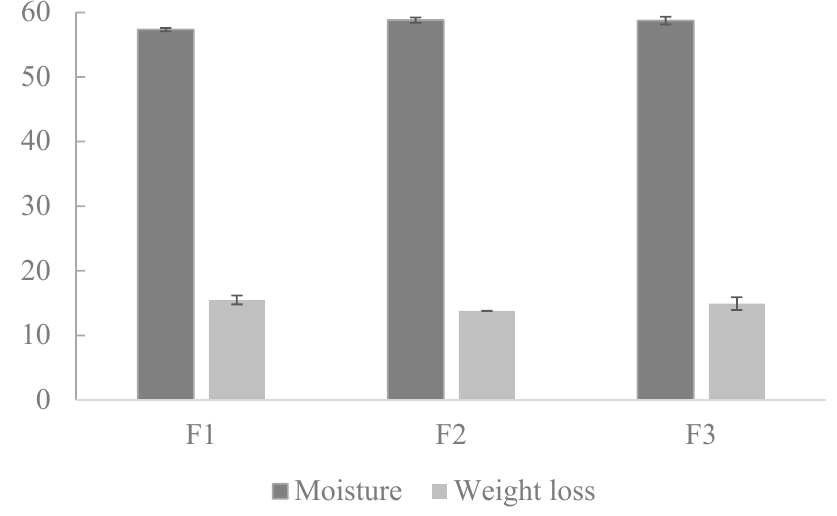
Figure 1. Weight loss and moisture content: 100% of rhizome flour (F1); 100% of flour blended with hydrocolloids (F2 and